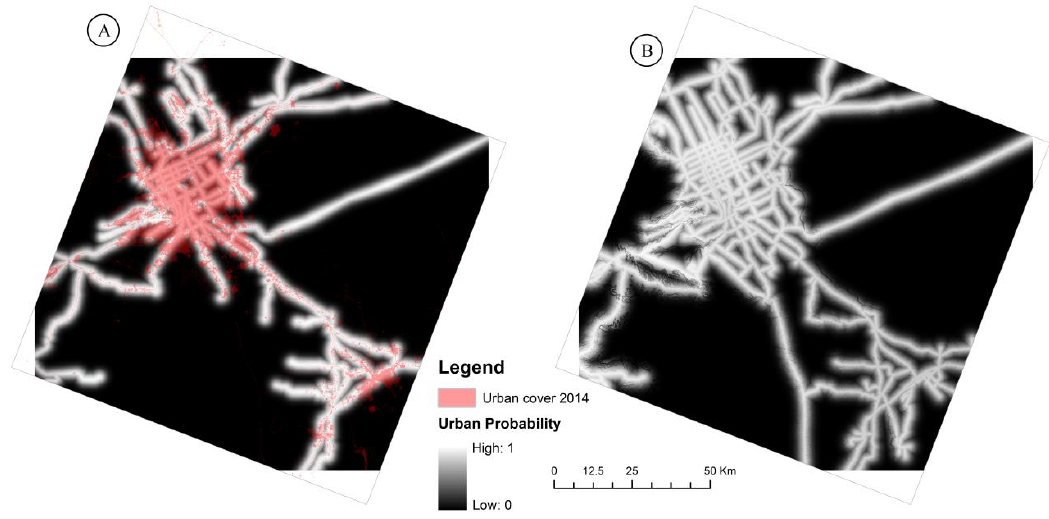
Figure 5. Urbanization probability maps in Riyadh ( A ) a comparison of the urban probability in 1985 and urban areas in 2014; ( B ) urban probability in 2014